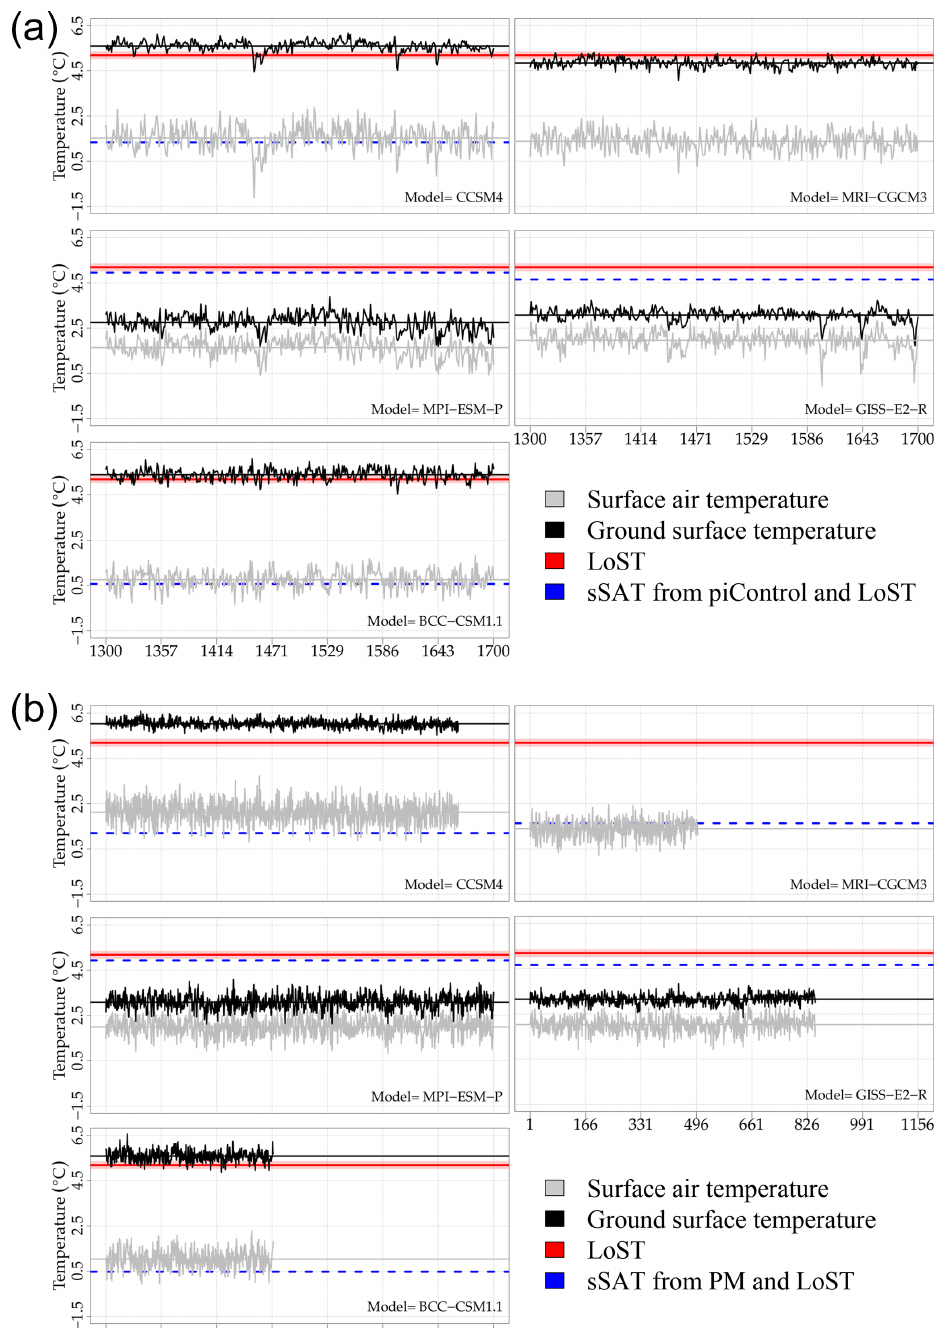
Figure 3. Surface air temperature evolution (gray solid line), ground surface temperature evolution (black solid line), SAT 0 (gray horizontal line) and GST 0 (black horizontal line) for (a) PMIP3/CMIP5 PM and (b) PMIP3/CMIP5 piControl simulations. Solid red lines represent the mean LoST temperature, and the red shadow represents the 95% confidence interval (Sect. S1, Fig. S6). Dashed blue lines represent estimated references for long-term surface air temperatures from the LoST climatology and the simulated air–ground temperature offset in (a) piControl and (b) PM simulations. Ground temperatures for the MRI-CGCM3 piControl simulation could not be retrieved from the PMIP3/CMIP5 data